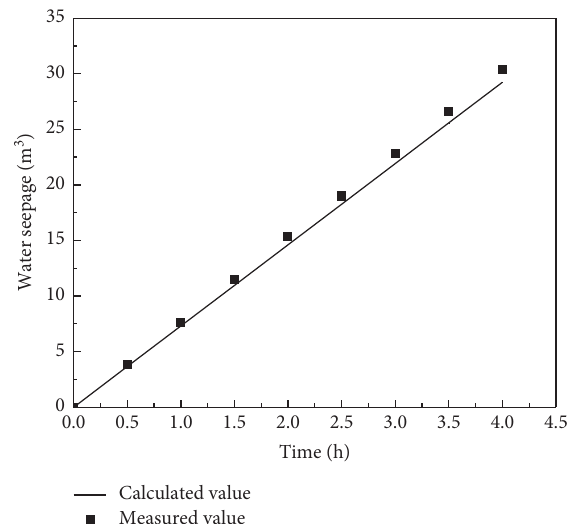
Figure 12: Influence of t on the moisture content of chamber soil when k � 10 − 5 m/s and α � 2/3.